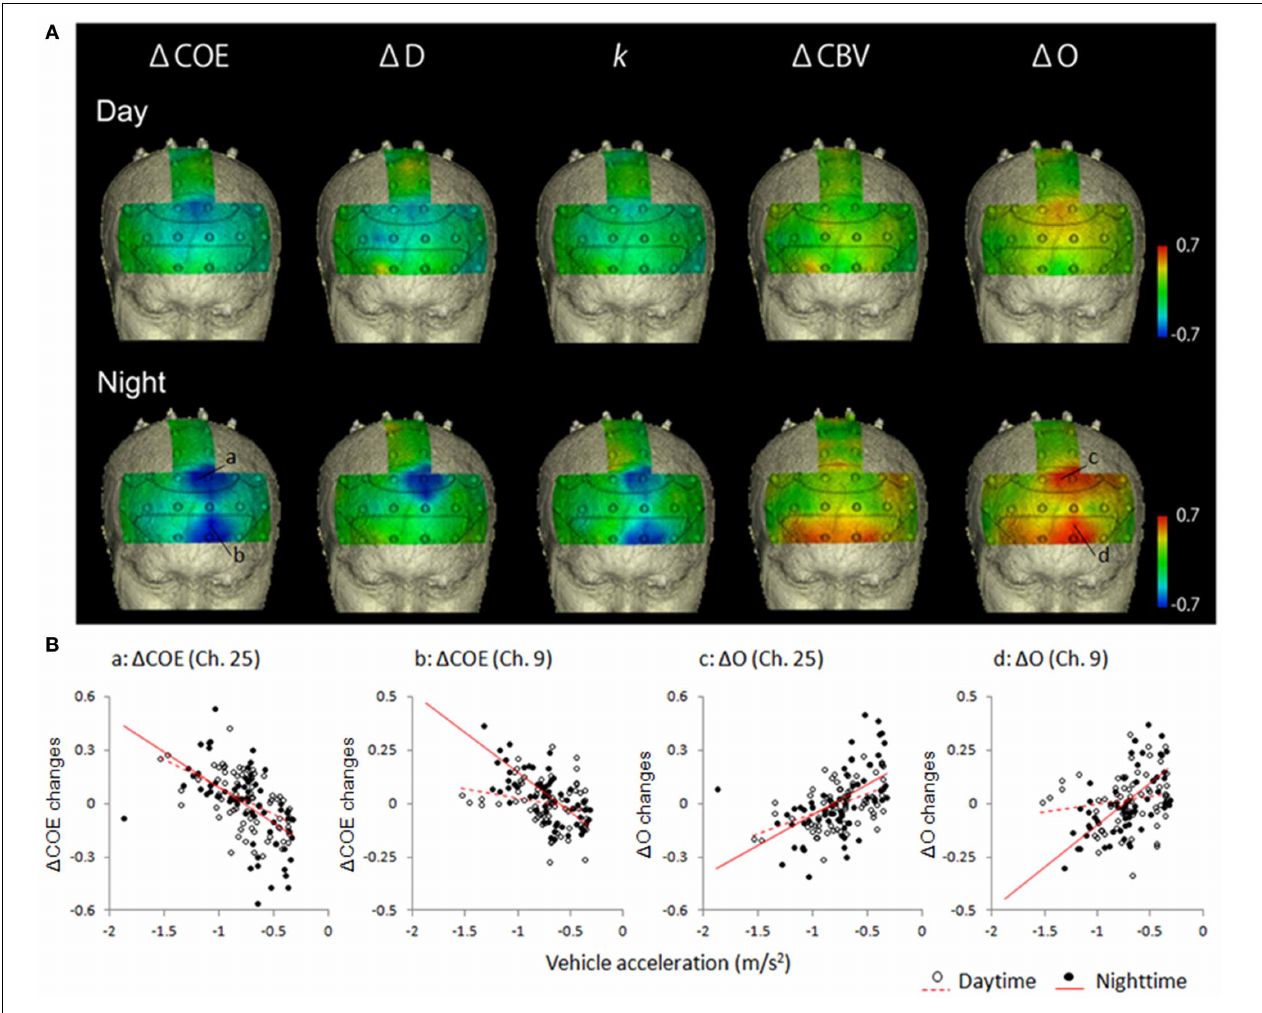
FIGURE 4 | Correlations in the speed reduction task between vehicle acceleration and each of the brain activation indices. (A) Correlation maps showing correlations between vehicle acceleration and each of the hemodynamic indices in the speed reduction task. (B) Correlation diagrams